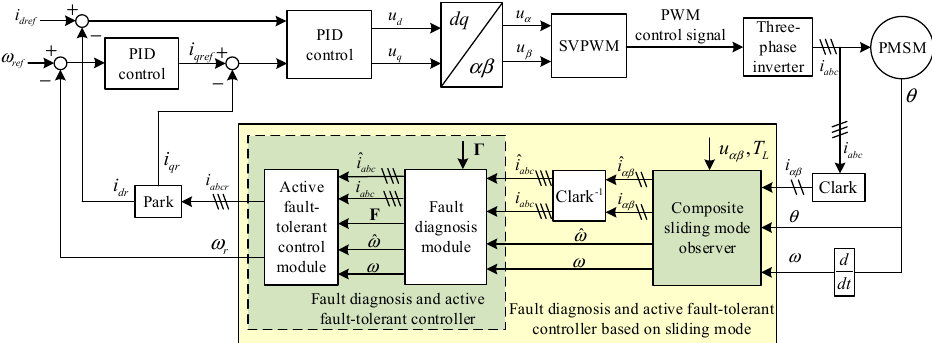
Figure 1. The schematic diagram of fault diagnosis and active fault-tolerant control system based on sliding mode.